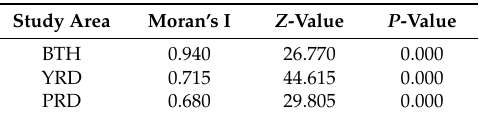
Table 2. Spatial autocorrelations of AOD in study areas. BTH = Beijing-Tianjin-Hebei region; YRD = Yangtze River Delta; PRD = Pearl River